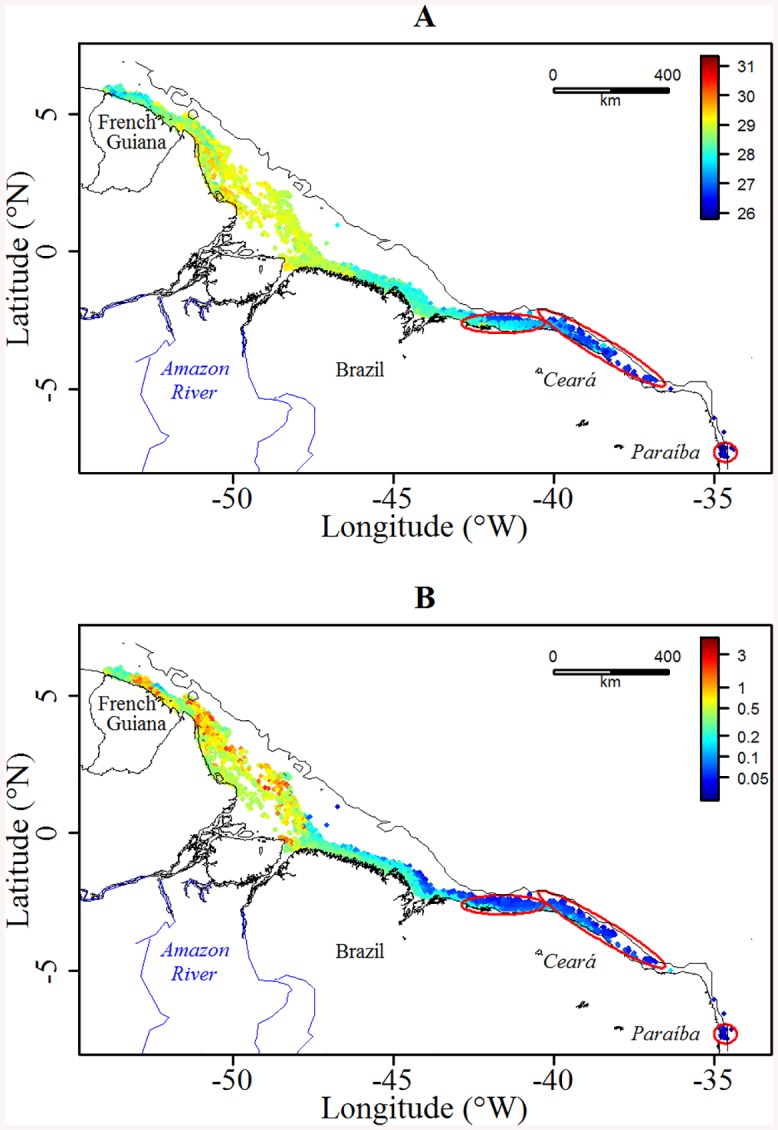
Distributions of (A) SST (°C) and (B) Kd (m-1) along the 19 turtles’ tracks.The foraging grounds are represented by the red ellipses and the black solid line refers to the 100 m isobaths. Kd refers to the Diffuse Attenuation Coefficient and was logged transformed for a better contrast. The shoreline was extracted from NOAA National Geophysical Data Center, Coastline.